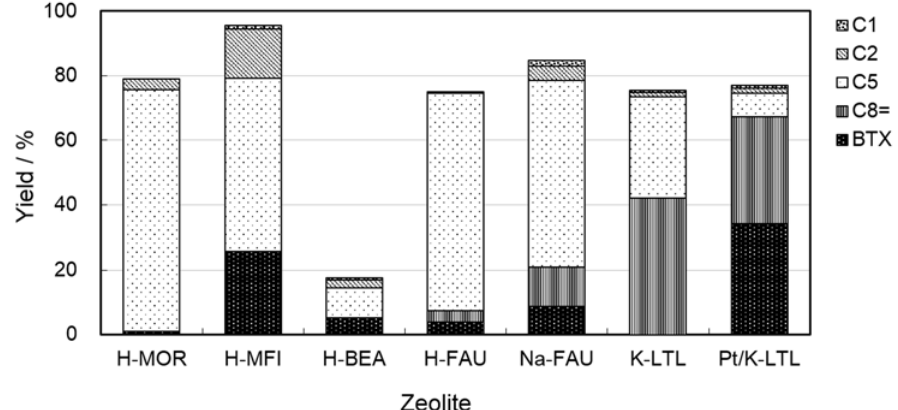
Figure 2. Effect of the zeolite structure on the catalytic activity of proton- or alkali ion–exchanged zeolites for reaction of 2-octanol at 773 K. Reaction conditions: catalyst 1.0 g; total gas flow rate 20 mL·min − 1 (GHSV 700 h − 1 ); P 2OcOH 5%; N 2 95%; 1